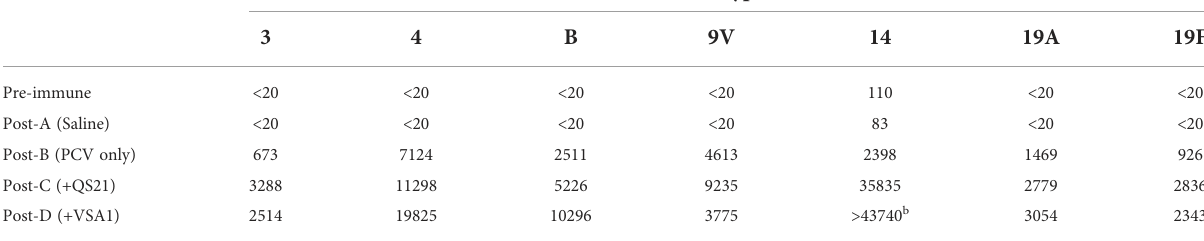
TABLE 2 OPA Titer to Different Vaccine Serotypes a . Sera